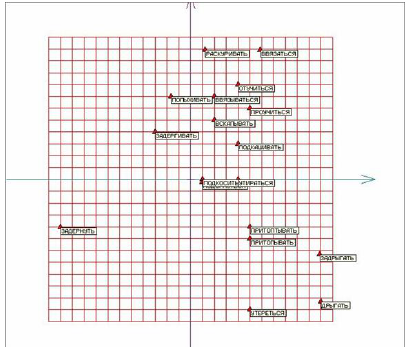
Figure 1. Extension of the elastic map after two consecutive quasi-Zoom applications